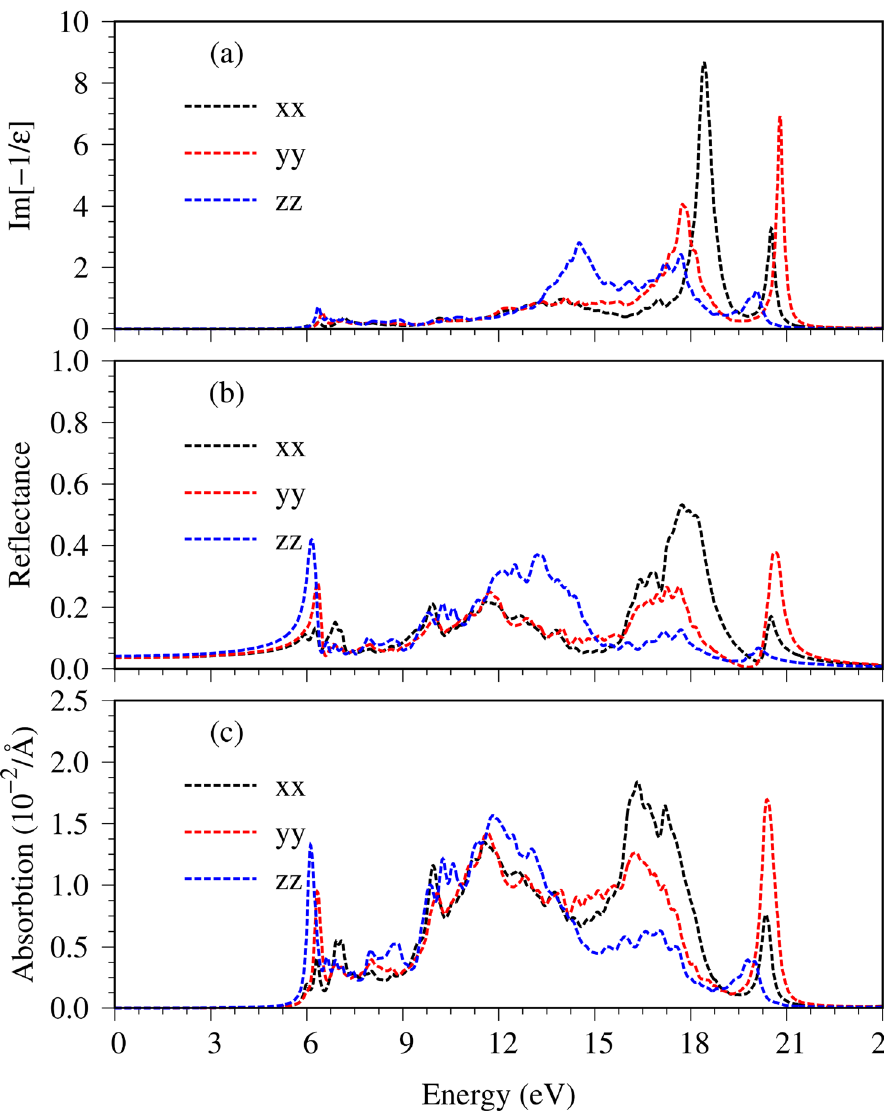
Figure 7. The various optical properties: ( a ) energy loss functions, ( b ) reflectance spectra, and ( c ) absorption high-frequency dielectric tensor ( ǫ 1 ( properties, and has far-reaching research signification.